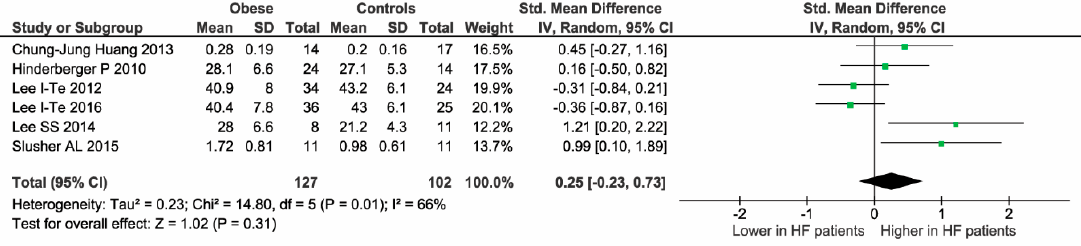
Figure 3. Sensitivity analysis after excluding the four low-quality studies.